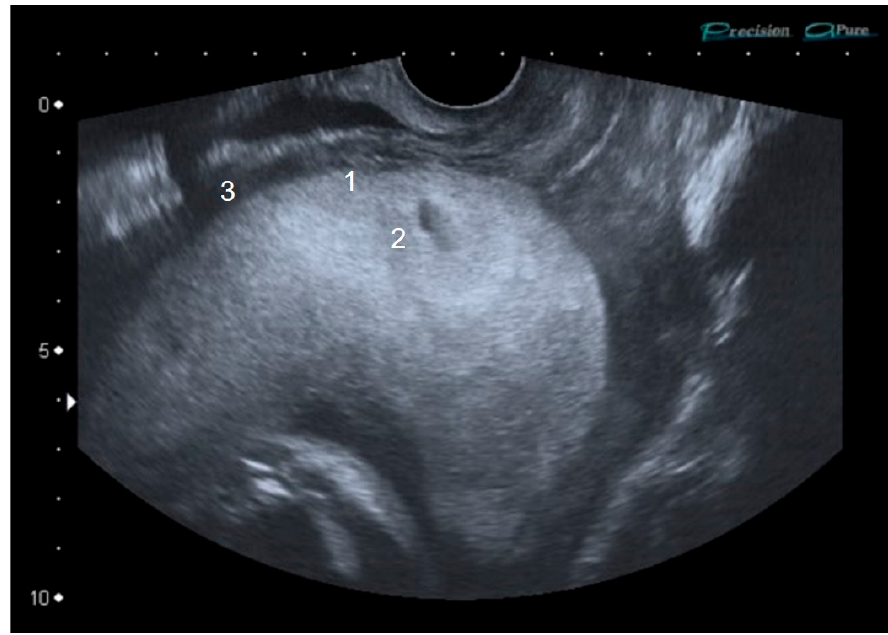
Figure 1. Ultrasound image. Placenta previa at 33 weeks of gestation. (1) The clear zone cannot be visualized. (2) Scarce placental lacunae. (3) Myometrial thinning.